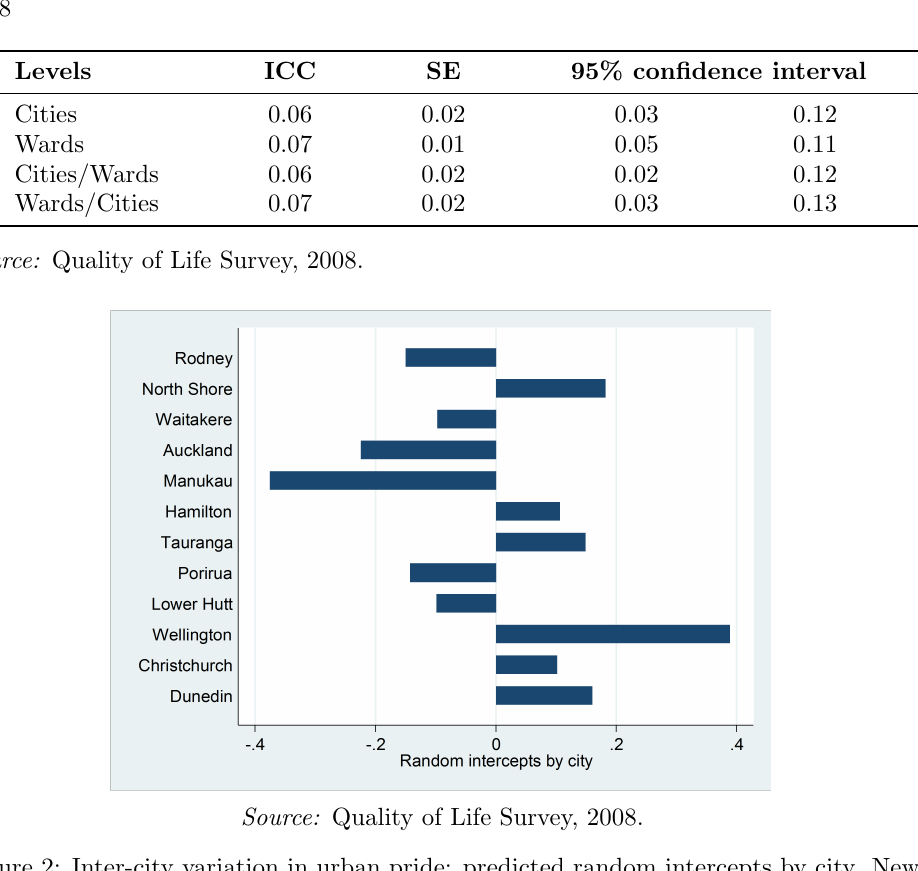
Figure 2: Inter-city variation in urban pride: predicted random intercepts by city. New Zealand